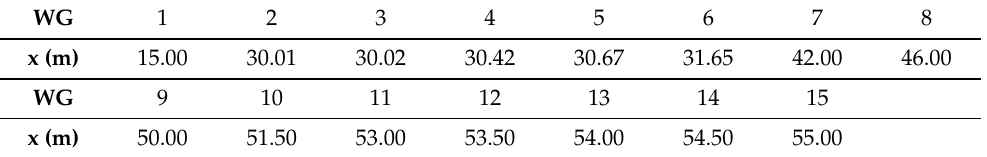
Table 2. Position of wave gauges in the physical experiment.